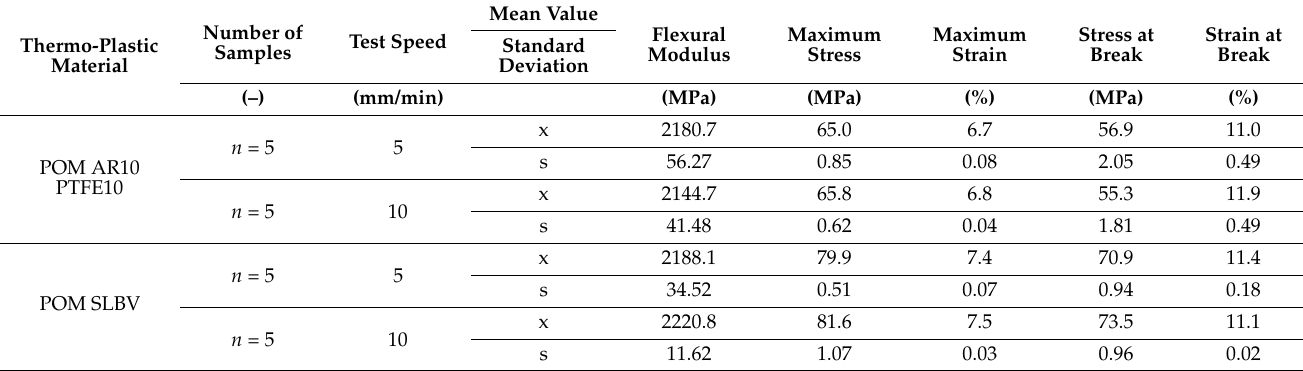
Table 5. Mechanical properties of the POM copolymers determined in a three-point bending test according to DIN EN ISO 178. Number of Thermo-Plastic Samples Material